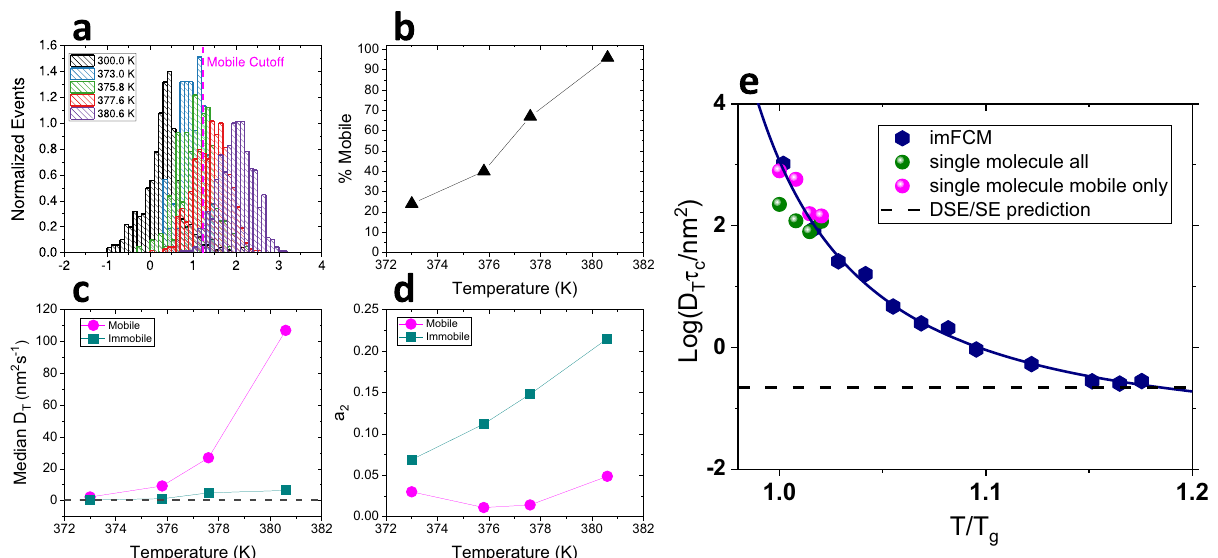
Fig. 3 Analysis of mobile and immobile single molecule trajectories. ( a ) Distributions of time-normalized radii of gyration. Mobile cutoff was determined to be 16.9nm, as indicated by the pink dashed line. ( b ) Percentage of molecules identi fi ed as mobile increases as a function of temperature. ( c ) Median diffusion coef fi cients for mobile and immobile molecules as a function of temperature. Dashed line indicates median D T from 300.0K baseline data with only